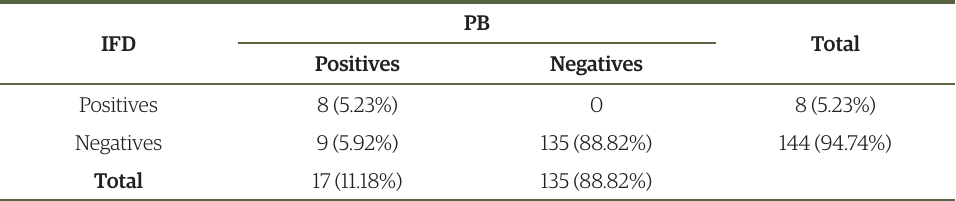
Table 2. Comparison between the results of the fluorescent antibody test (IFD) and mouse inoculation test (PB) in horses, SDZ from 2001 to 2015.